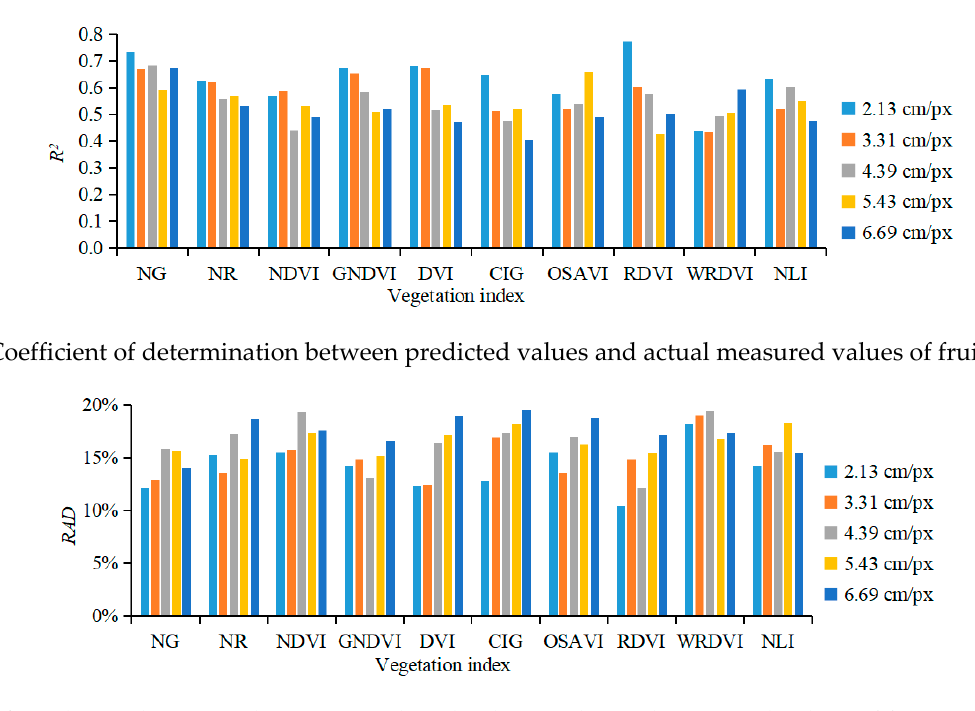
Figure 6. Performance parameters of the fruit yield prediction model using various vegetation indices. When GSD was 2.13, 3.31, 4.39, 5.43, and 6.69 cm / px, for Input 2, the R 2 of the BPANN